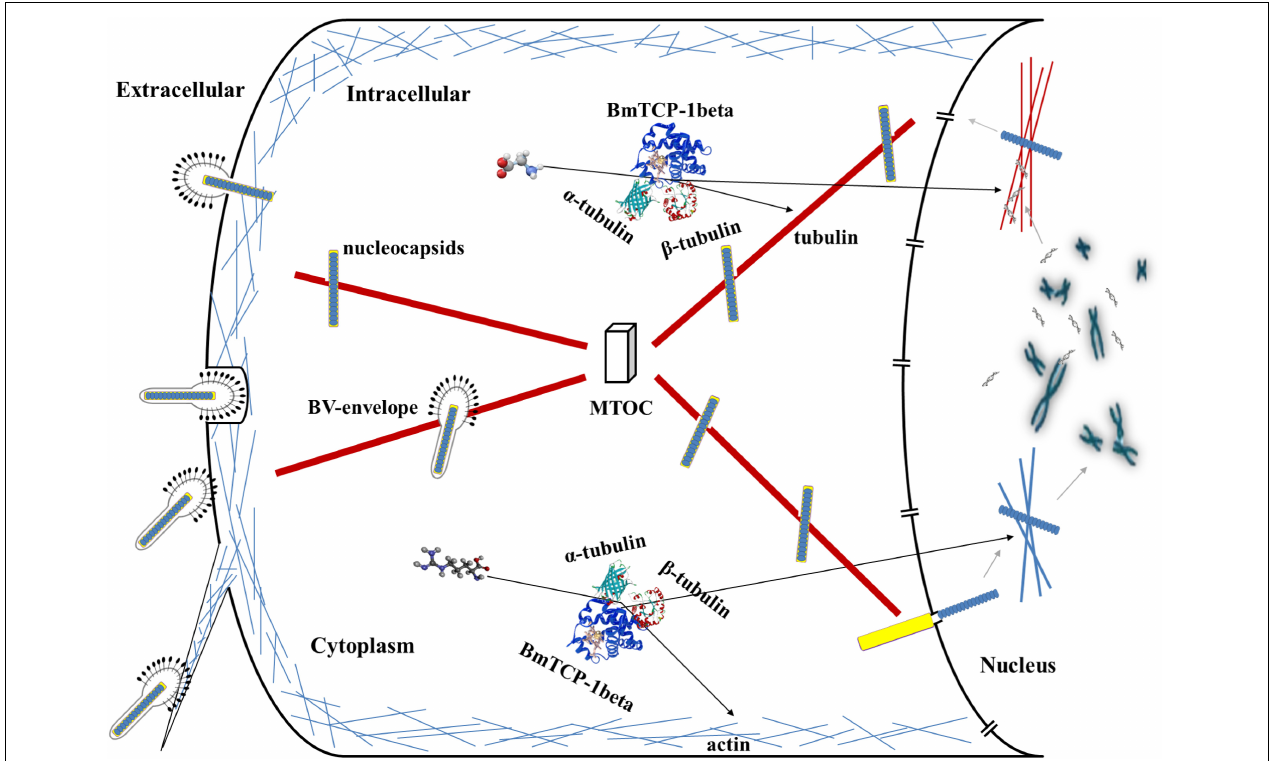
FIGURE 7 | Hypothesized roles of BmTCP-1 β in the response to BmNPV infection. MTOC, microtubule-organizing center.